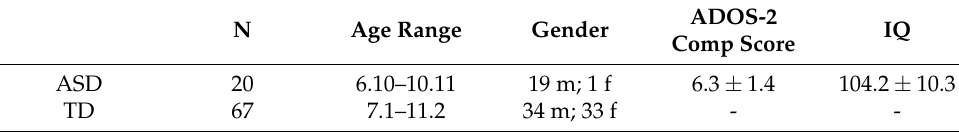
Table 2. Clinical and demographic features of participants per